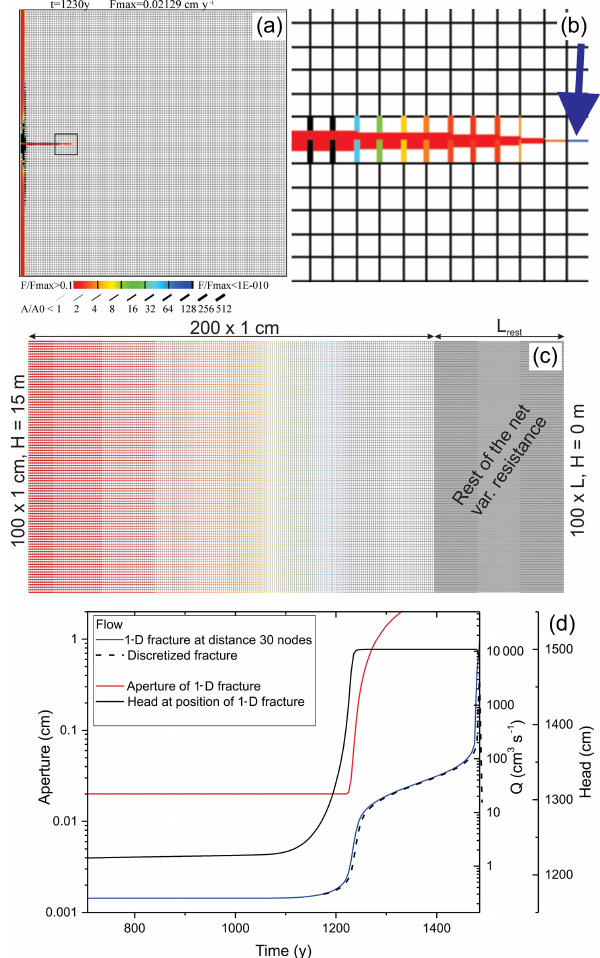
Figure 23. (a) Two-dimensional network with penetrating worm- hole. (b) Excerpt of an area marked by a square in (a) . Blue arrow marks the position of a fracture discretized into the 2-D domain. (c) Two-dimensional model of an elementary fracture. It shows a front of even dissolution. Right-hand part (grey rectangle) shows a set of parallel fractures with time-dependent resistances, appended to the outlet of the 2-D fracture. (d) Evolution of aperture width (red line), hydraulic head at the input (black line), and flow rate (blue line) for the fracture marked by an arrow in (b) . Evolution of flow rate in a 2-D analog is shown by the dashed black